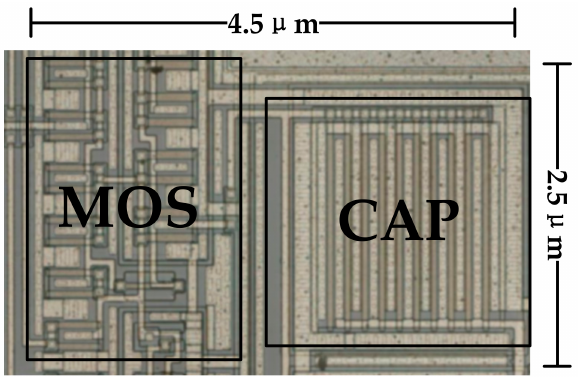
Figure 13. The layout photo of the designed neuron circuit, with area 13 µ m 2 .